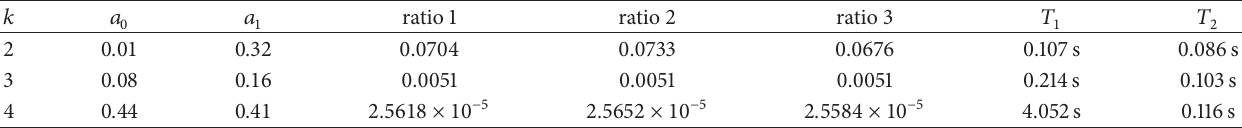
Table 1: The error ratios (i.e., ratio 1, ratio 2, and ratio 3) corresponding to different 𝑘 , 𝑎 0 , and 𝑎 1 . 𝑇 1 and 𝑇 2 are the time cost by direct computing and Algorithm 7,